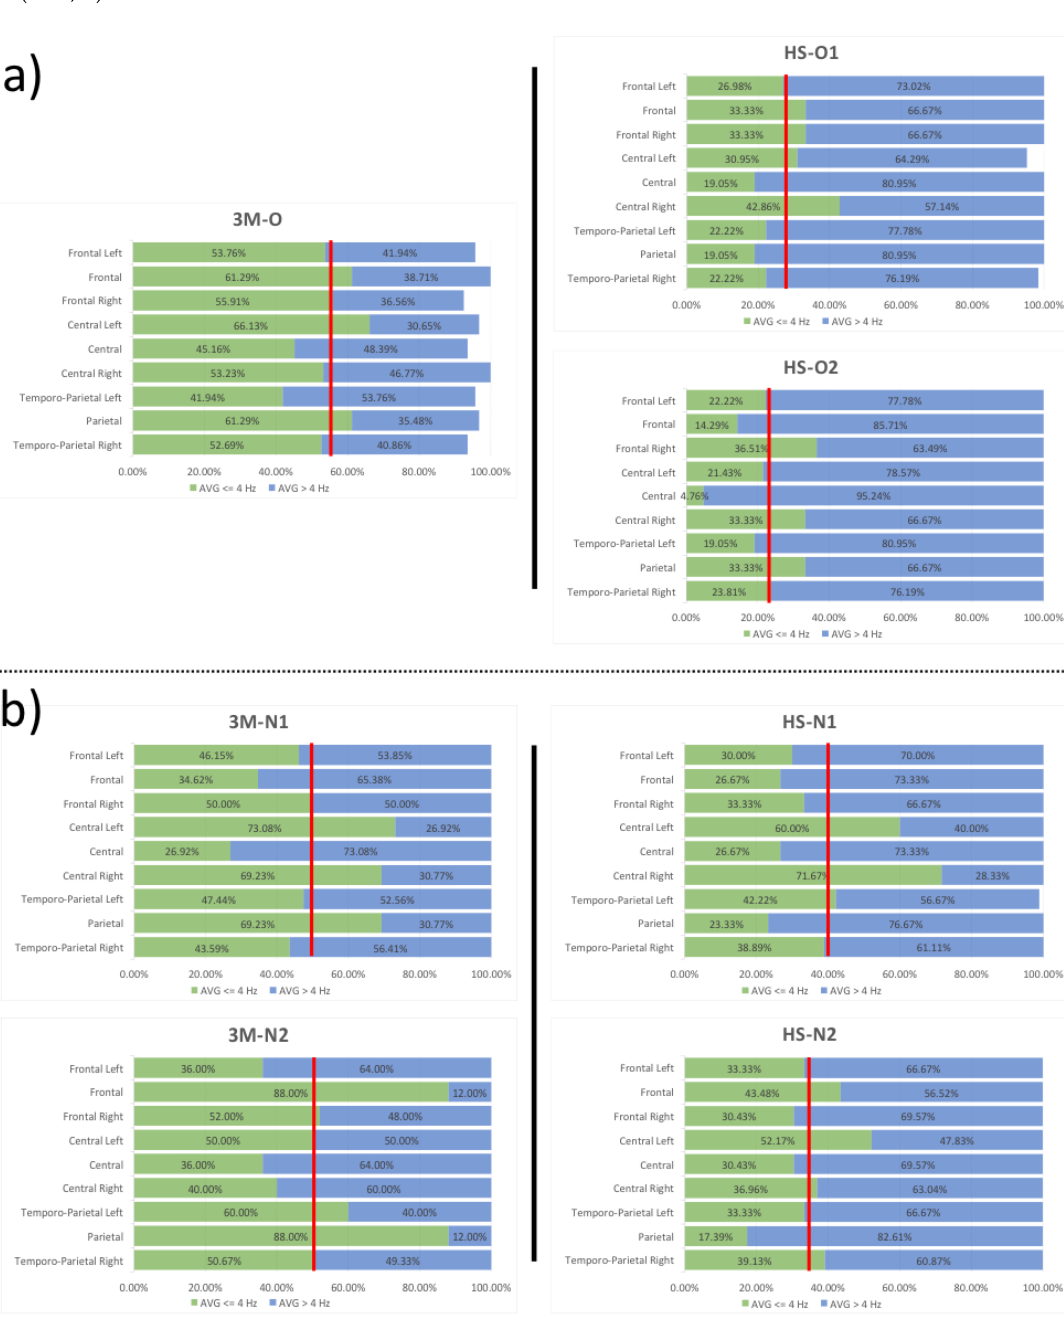
Figure 3. Representation of the percentage of trials (horizontal axis) divided by ROIs (vertical axis), for which 60% of the power spectrum area was ≤ 4 Hz (green) or > 4 Hz (blue) for each of the treated infants. A sum less than 100% indicates that some trials were too corrupted to be treated and, hence, discarded; this phenomenon mainly occurred for subject 3M-O. Data regarding subject 3M-O and the corresponding controls HS-O1/HS-O2 are reported in a ) and 3M-N1/3M-N2 and the corresponding shared controls are reported in b ). Vertical bars indicate the average threshold; differences are apparent between patients and controls.